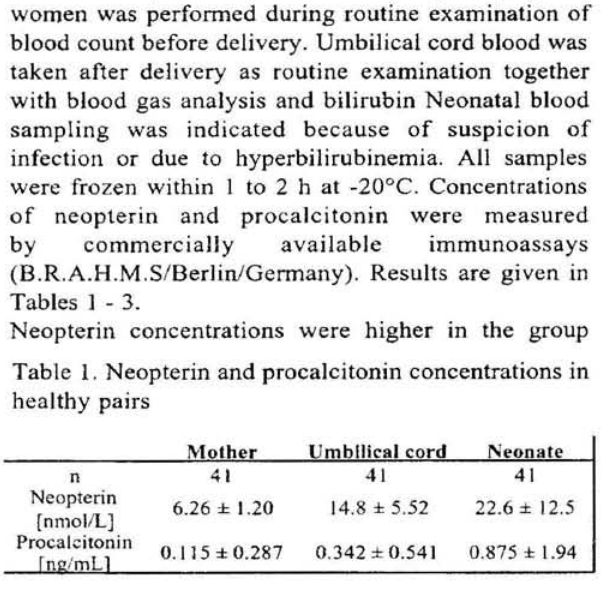
Table 1. Neopterin and procalcitonin concentrations in